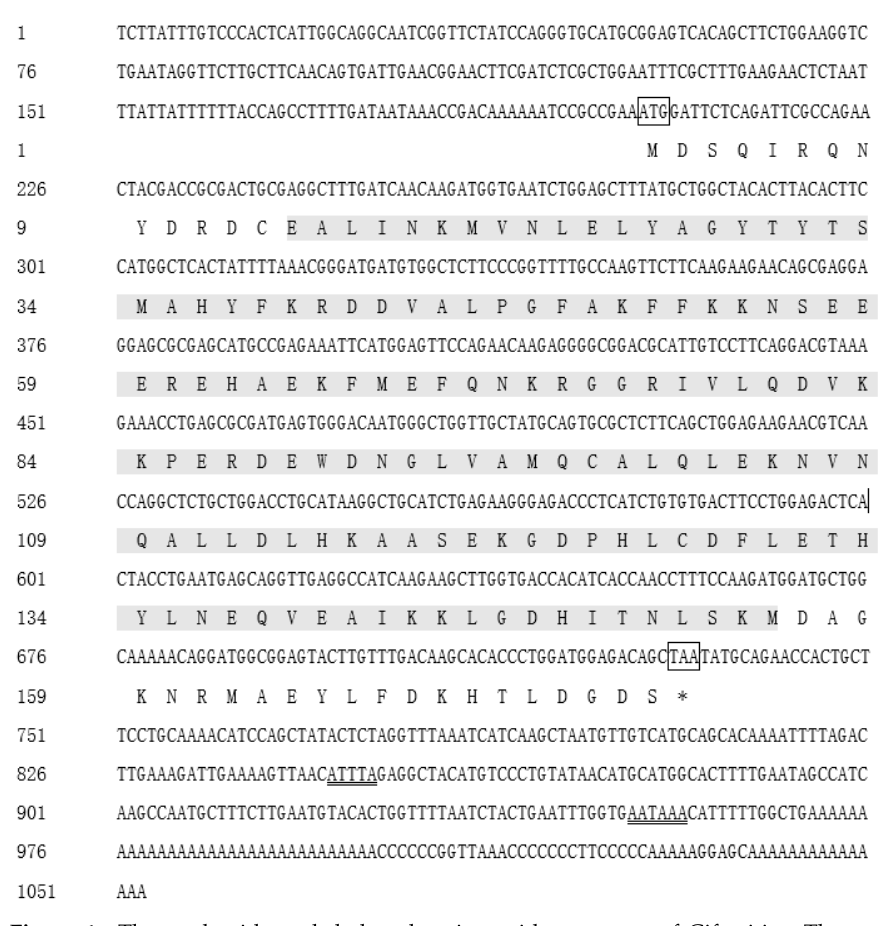
Figure 1. The nucleotide and deduced amino acid sequences of Ciferritin. The start codon is highlighted by the box, and the termination codon is marked with “*” and a box. The main domain of eukaryotic ferritin is marked with a gray shadow. The mRNA unstable motif (ATTTA) and polyadenylate termination signal (AATAAA) are double-un- derlined.